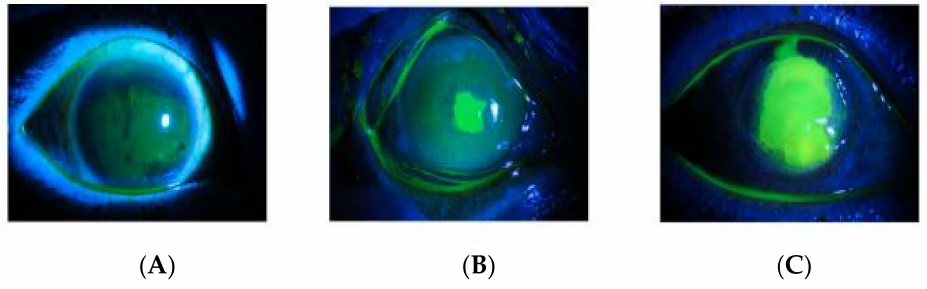
Figure 2. ( A ) point-like, ( B ) point-flaky, ( C ) and flaky